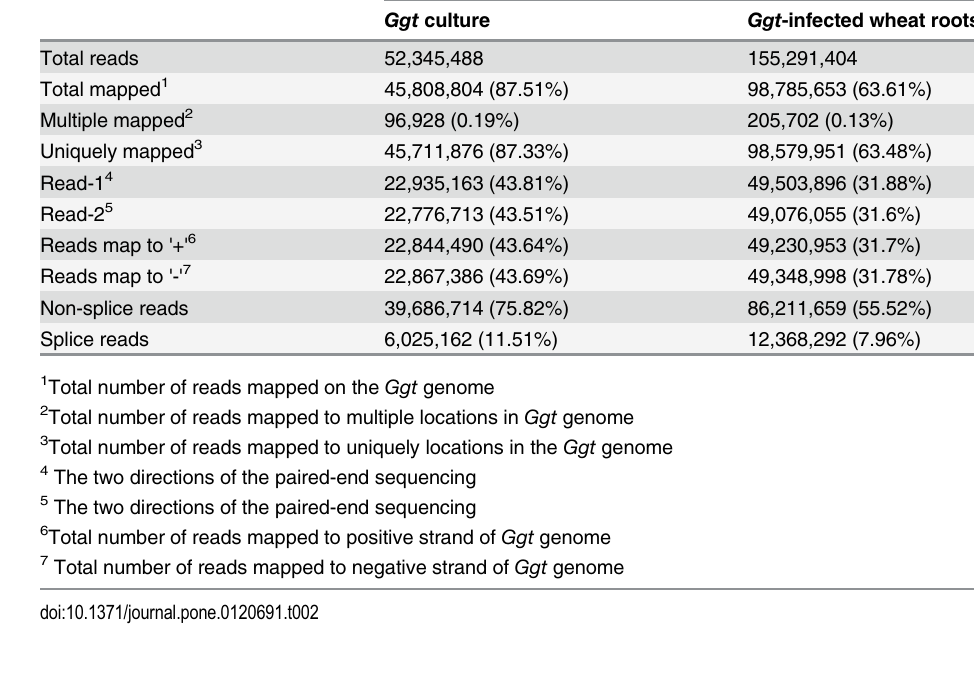
Table 2. Summary of mapping the sequenced reads to the Ggt genome from the 5 day old culture of Ggt and 7 day old Ggt -infected wheat roots. Event of mapping